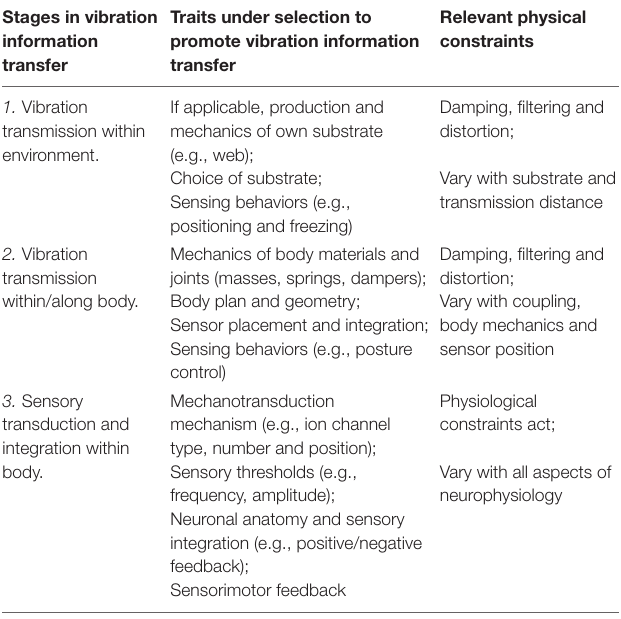
TABLE 1 | The focus of this review is vibration transmission, which is in the physical realm and involves mechanical vibrations propagating through the environment (Stage 1) and body (Stage